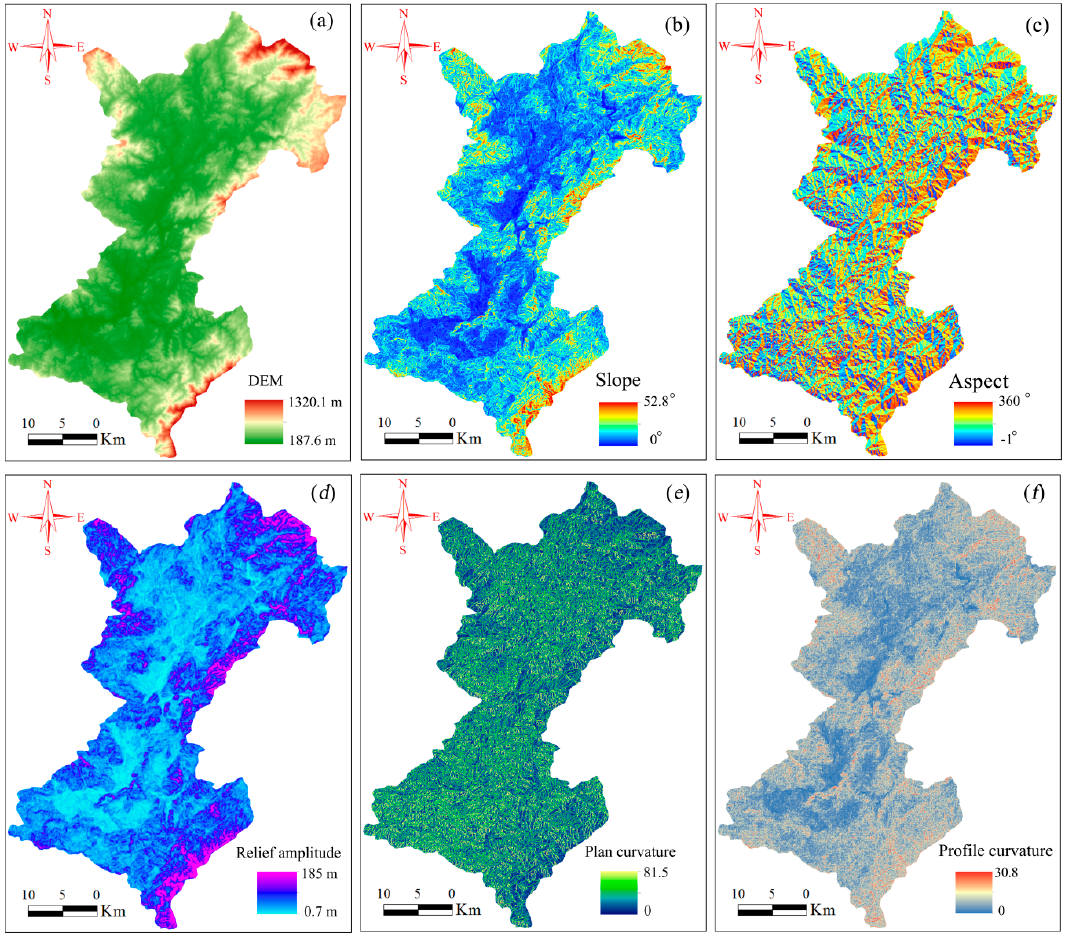
Figure 2. Topography factors in Shicheng County: ( a ) DEM, ( b ) Slope, ( c ) Aspect, ( d ) Relief amplitude, ( e ) Plan curvature, ( f ) Profile curvature. (2) Hydrological, lithological, and land cover factors